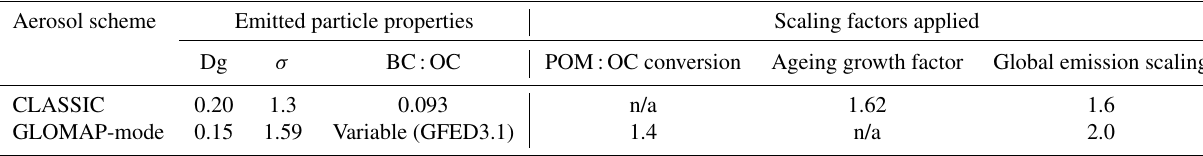
Table 1. Biomass burning aerosol emissions: emitted particle properties and scaling factors applied. Aerosol scheme Emitted particle